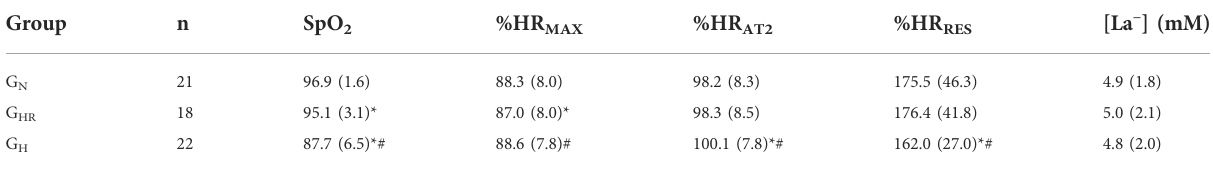
TABLE 1 Training characterization of the main part of exercise through peripheral oxyhemoglobin saturation (SpO 2 ), heart rate (HR), and the blood lactate concentration ([La − ]) over the 8 weeks of intervention.